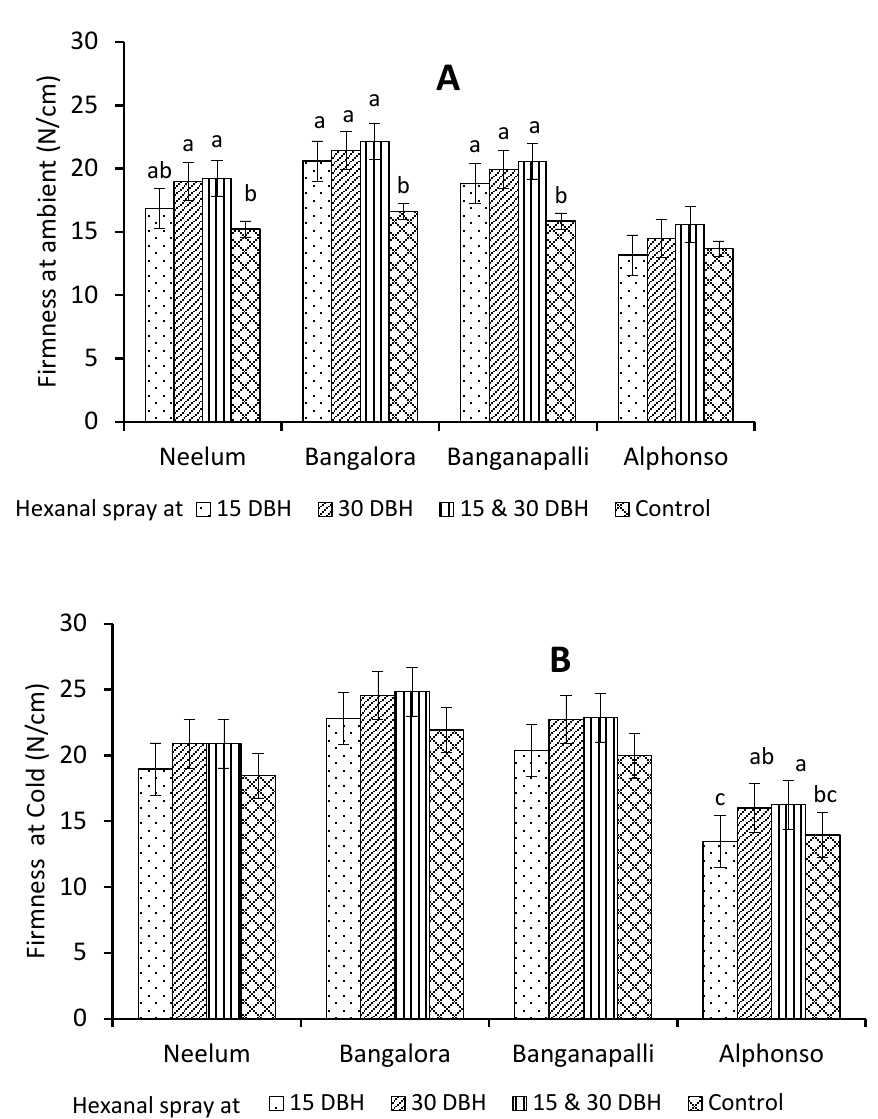
Figure 2. Mean firmness of the hexanal-treated and control mango fruits of four cultivars towards the end of the storage life under ambient ( A ) and cold ( B ) storage conditions. Vertical bars in the columns represent the standard error of four replicates (n = 15). The columns with and without or same letters indicate statistical significance and non-significance, respectively ( p = 0.05). DBH-Days before harvest.